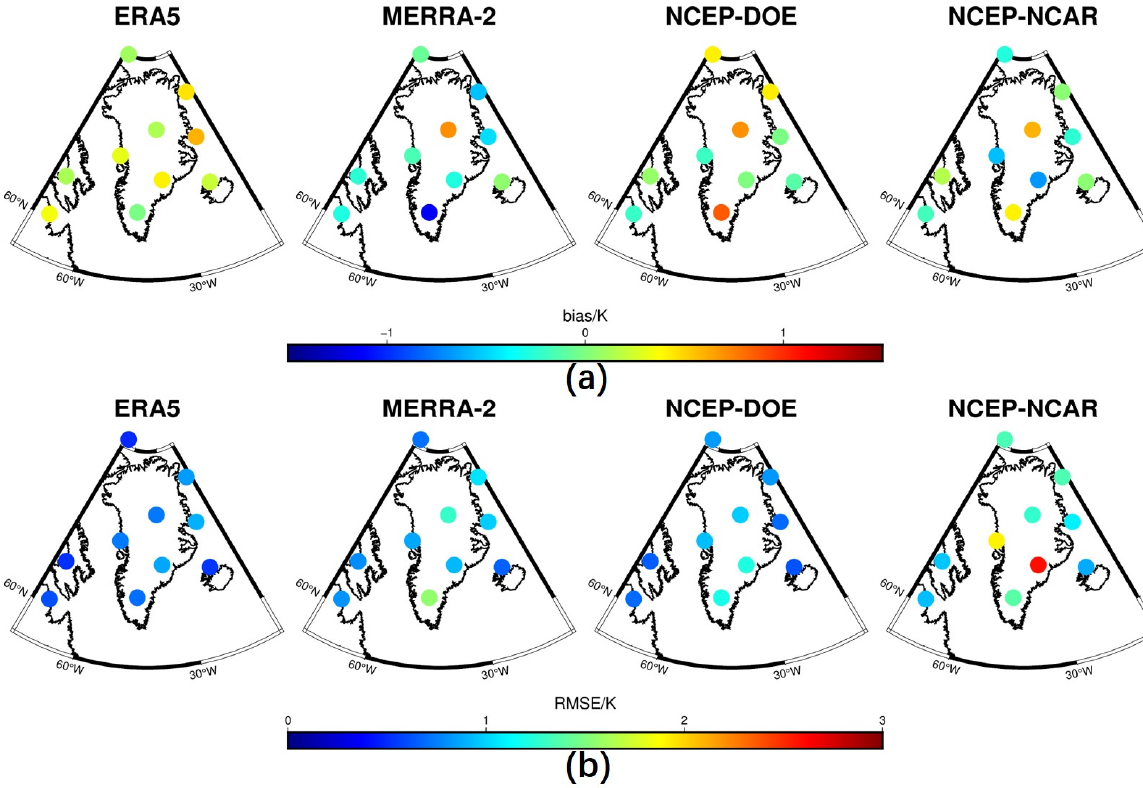
Figure 2. The 15-year mean ( a ) bias and ( b ) RMSE for the T m of 10 stations derived from four rea- nalyses. Table 3. The 15-year mean bias and RMSE values for the T (cid:2923) of 10 stations derived from four reanalyses.